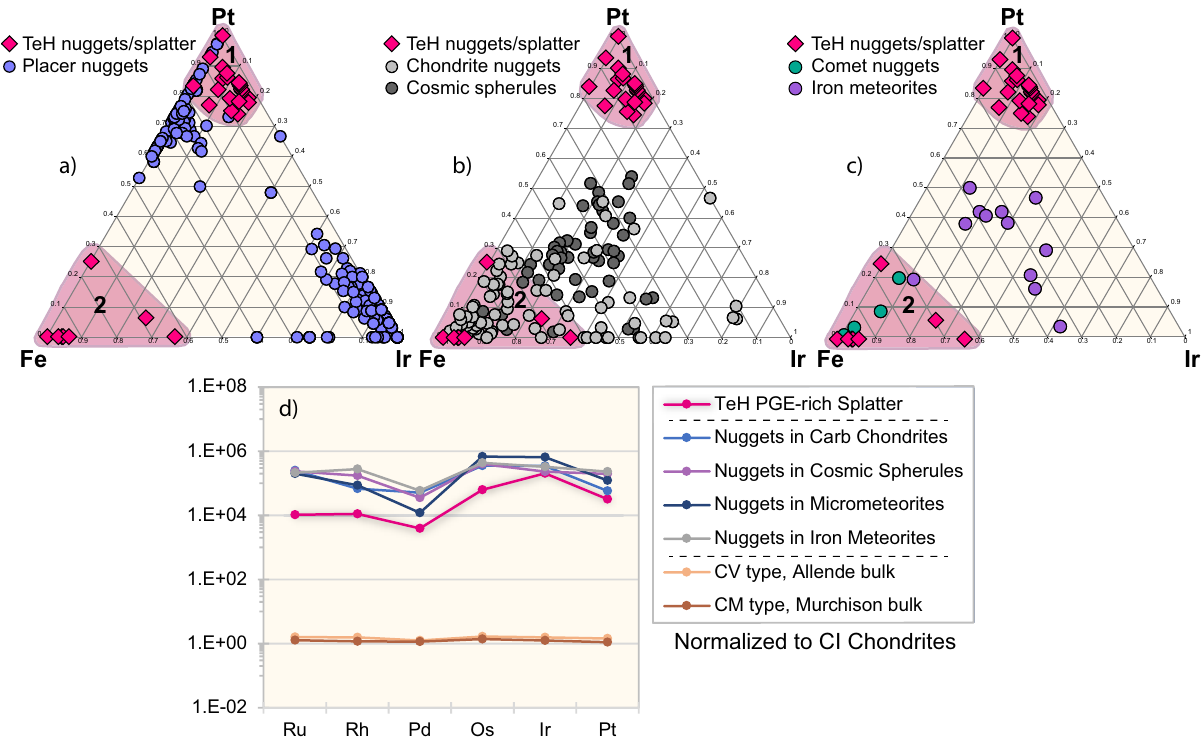
Figure 36. Ternary diagrams for PGE-rich grains. Comparison of Fe–Ir–Pt ratios of PGE-rich nuggets fused into the surfaces of TeH meltglass. There are two populations of TeH nuggets (red diamonds): Pt-dominant at #1 (top) and Fe-dominant at #2 (bottom left). ( a ) TeH Pt-dominant nugget group #1 (red diamonds) overlaps Pt-dominant but not Ir-dominant nuggets (blue circles) from placers and ophiolite deposits in Greece, Turkey, Iraq, Russia, Canada, and the USA. The Fe-dominant TeH nugget group #2 is geochemically dissimilar to all known placer nuggets, suggesting that these nuggets are not placer-derived. ( b ) TeH nuggets (red diamonds) compared to nuggets in carbonaceous chondrites (light gray circles) and nuggets in cosmic spherules (dark gray circles). Pt-dominant TeH nuggets in group #1 are a poor match, but Fe-dominant TeH splatter is an excellent match with chondritic meteorites and cosmic spherules, suggesting that they may be extraterrestrial in origin and that the impactor may have been a chondrite. ( c ) TeH nuggets (red diamonds) are a poor match for most nuggets in iron meteorites (purple circles), but an excellent match for nuggets found in comets (green circles). These data suggest that Fe-dominant PGE nuggets at TeH may have originated from cometary material. ( d ) Semi-log comparison of PGEs ruthenium (Ru), rhodium (Rh), palladium (Pd), osmium (Os), iridium (Ir), and platinum (Pt), normalized to CI chondrites. TeH Fe-dominant splatter (red line) is an excellent match for PGE nuggets in carbonaceous chondrites (blue line), cosmic spherules (purple line), micrometeorites (dark blue line), and iron meteorites (gray line). In contrast, TeH PGE nuggets are a poor match for bulk material from CI-normalized CV-type chondrites (e.g., Allende; orange line) and CM-type chondrites (e.g., Murchison; brown